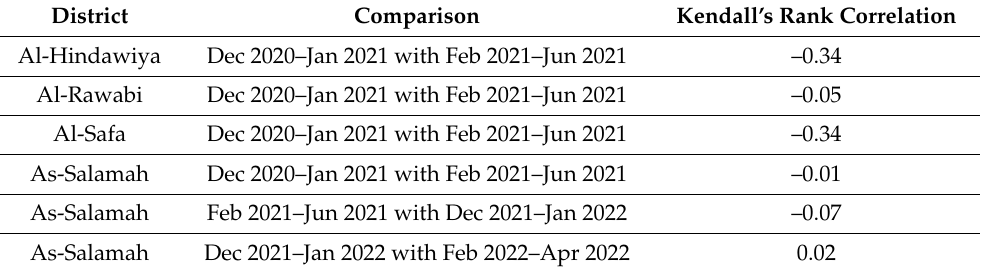
Table A8. Correlation in modelled mosquito presence surfaces for trap collection locations.